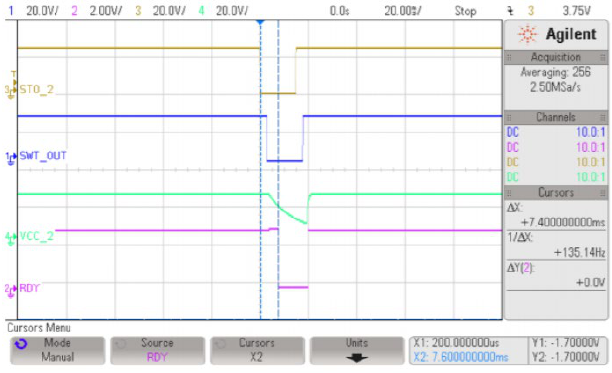
Figure 4. Propagation of STO2 to secondary supply of gate driver